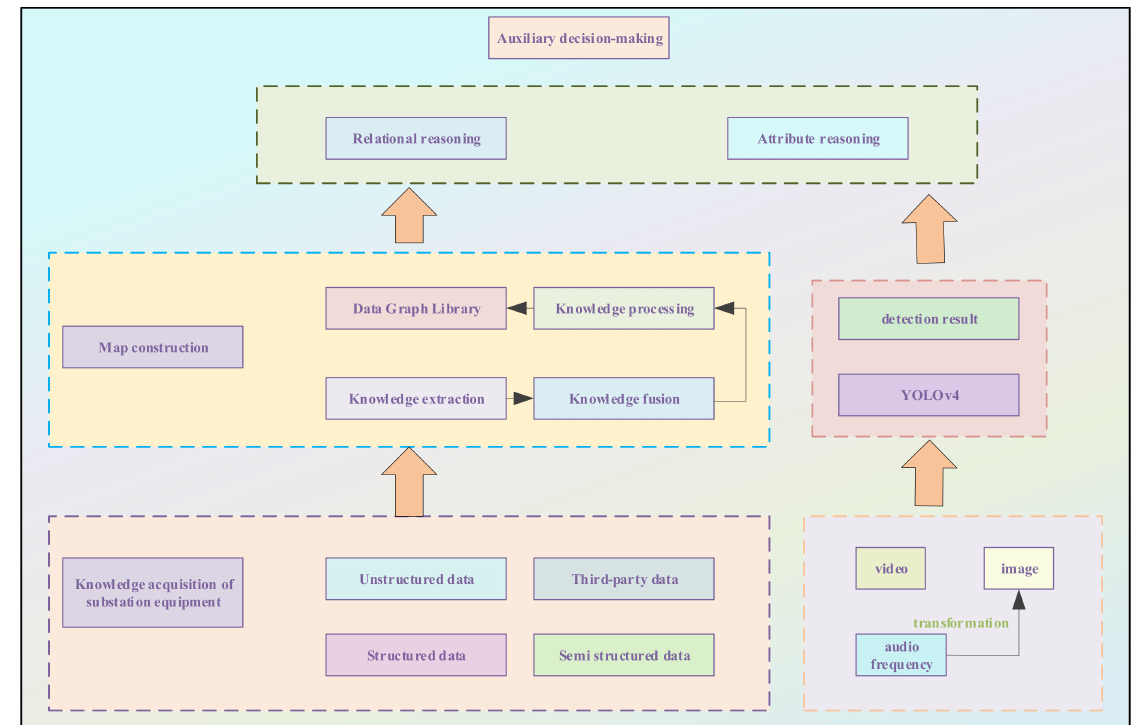
Figure 6. Technical framework of the overall